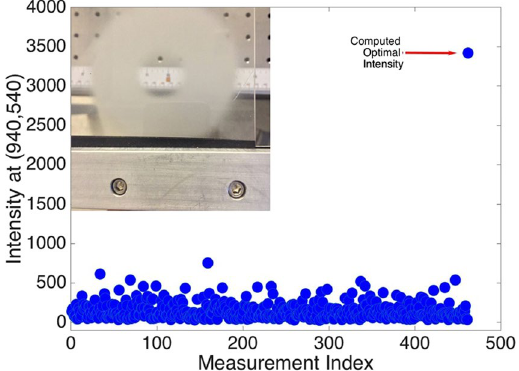
Figure 3. ( a ) Groundglass sample. ( b ) A plot of the intensity b